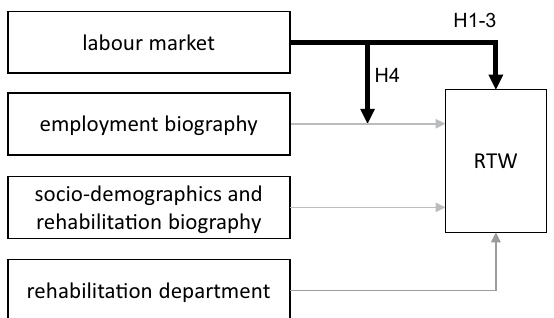
Fig. 1 Effect relationships and hypotheses (H)